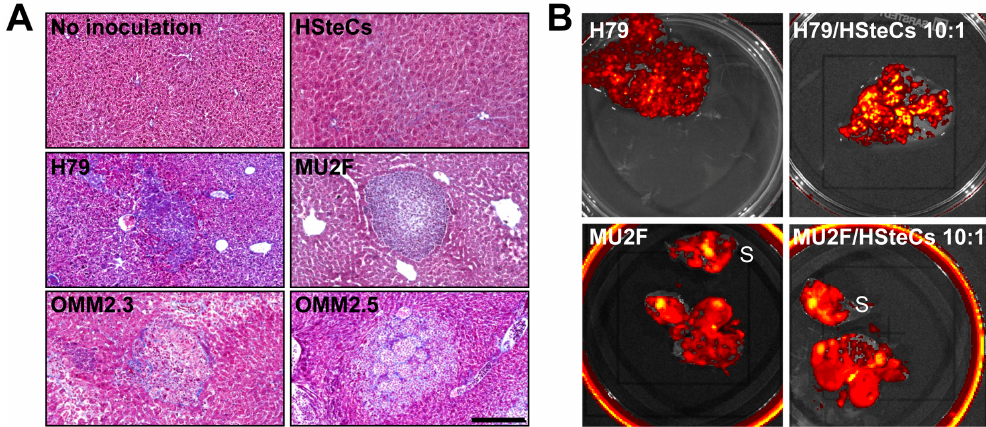
Figure A1. HSteCs are activated by various metastatic UM cell lines. ( A ) The Masson’s Trichrome (MT) stain reveals the production of collagen by HSteCs (in blue) in the vicinity of malignant lesions generated in triple-immunodeficient mice using metastatic UM cell lines H79, MU2F, OMM2.3 and OMM2.5. There is no malignant lesion in control groups without inoculation of human cells or inoculated with human HSteCs alone. Scale bar, 50 µm. ( B ) Ex vivo fluorescence imaging of the liver of triple-immunodeficient mice bearing UM metastases generated with H79 and MU2F cell lines inoculated alone or in combination with human HSteCs (ratio 10:1). S = spleen. The red to yellow signal corresponds to malignant lesions at 6 weeks post-inoculation.